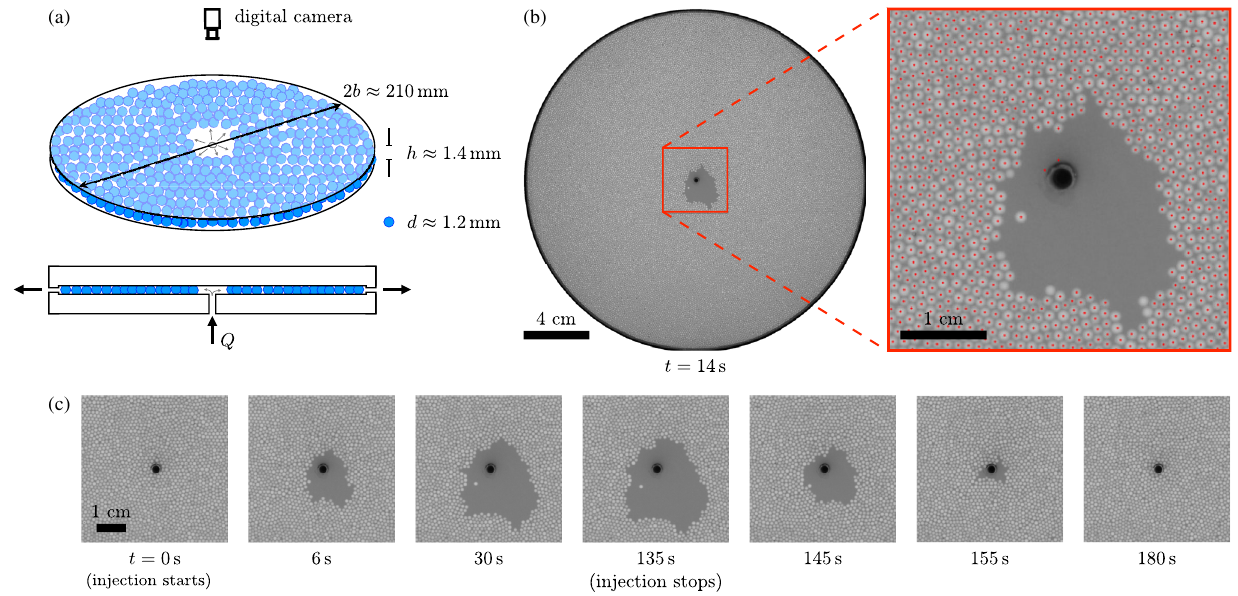
FIG. 1. We inject fluid into a monolayer of soft particles and measure the resulting poromechanical deformation. (a) The particles are confined between two rigid glass disks of radius b ≈ 105 mm, and we inject fluid into the center of the packing at a steady volume rate Q . The fluid flows radially outward through the packing and exits along the rim through a permeable spacer. The pressure gradient due to fluid flow through the packing drives the particles radially outward, opening a cavity in the center that relaxes and closes after injection stops. (b) We image the experiment from above with a digital still camera, measuring the deformation field at high resolution by identifying and tracking the individual particles (see Appendix A). This snapshot is during injection at Q ¼ 24 mL = min. (c) Sequence of snapshots from the same experiment showing cavity opening and relaxation. The black circle in the center is the injection port in the bottom disk, which has a diameter of about 2.5